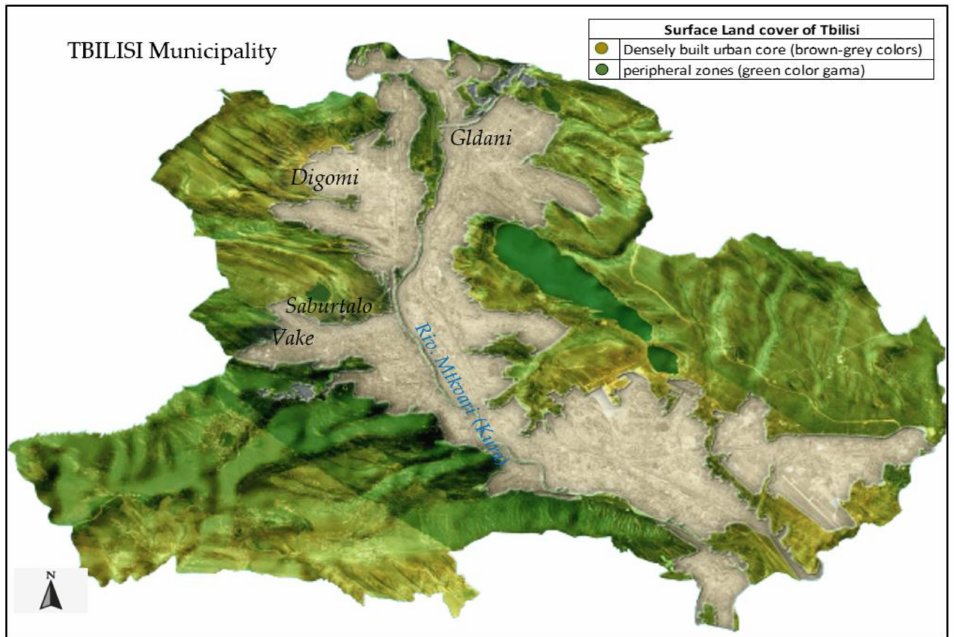
Figure 1. Distribution of densely built urban core and peripheral landscape zones in Tbilisi Munici- pality. Schematic image -The image is made by merging of isohypse and aerial photos (source: City Institute Georgia. 2017. Tbilisi Land-use Plan. Vol. 4. Tbilisi Land Use Concept [29] (Adapted with permission from ref.